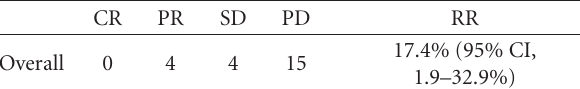
Table 2: Response (23 patients).